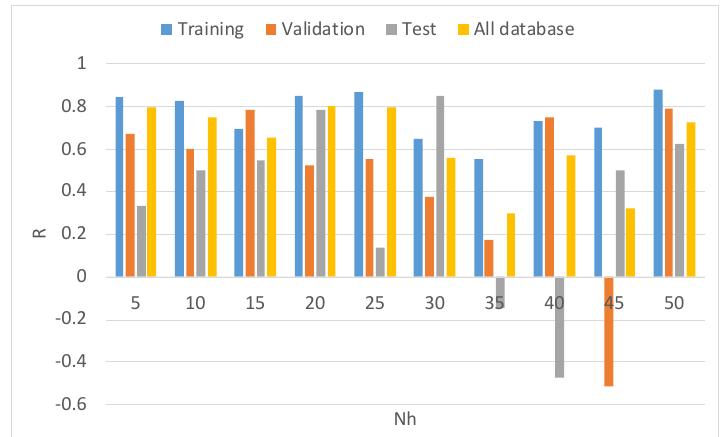
Figure 8. Pearson’s correlation coefficient R between the target and predicted solution time for one training, validation, and test part of the Dice 2 dataset and for the whole dataset varying the number of neurons ( N h ) in the hidden layer of the ANN